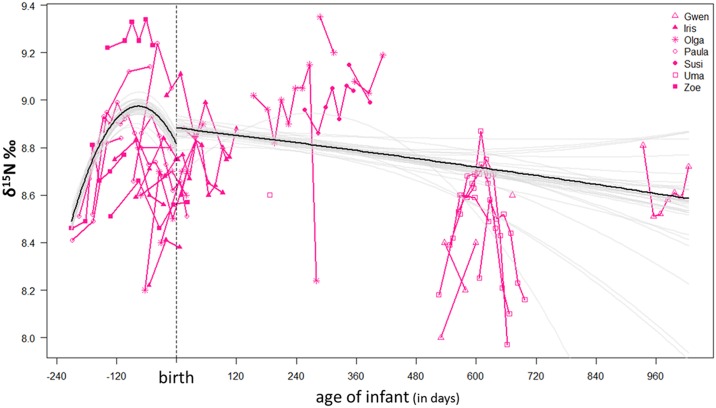
Post-hoc model on female bonobo reproductive status and age of infant.The relationship between the variation in δ15N values and reproductive status interacting with age of offspring was clearly significant, suggesting that δ15N values change during pregnancy and within the lactation period with increasing age of infant. The model stability is indicated as alternative model lines (in gray) which fit well during pregnancy but also illustrate that it is unstable for lactating females, particularly as infants become increasingly independent from their mothers.